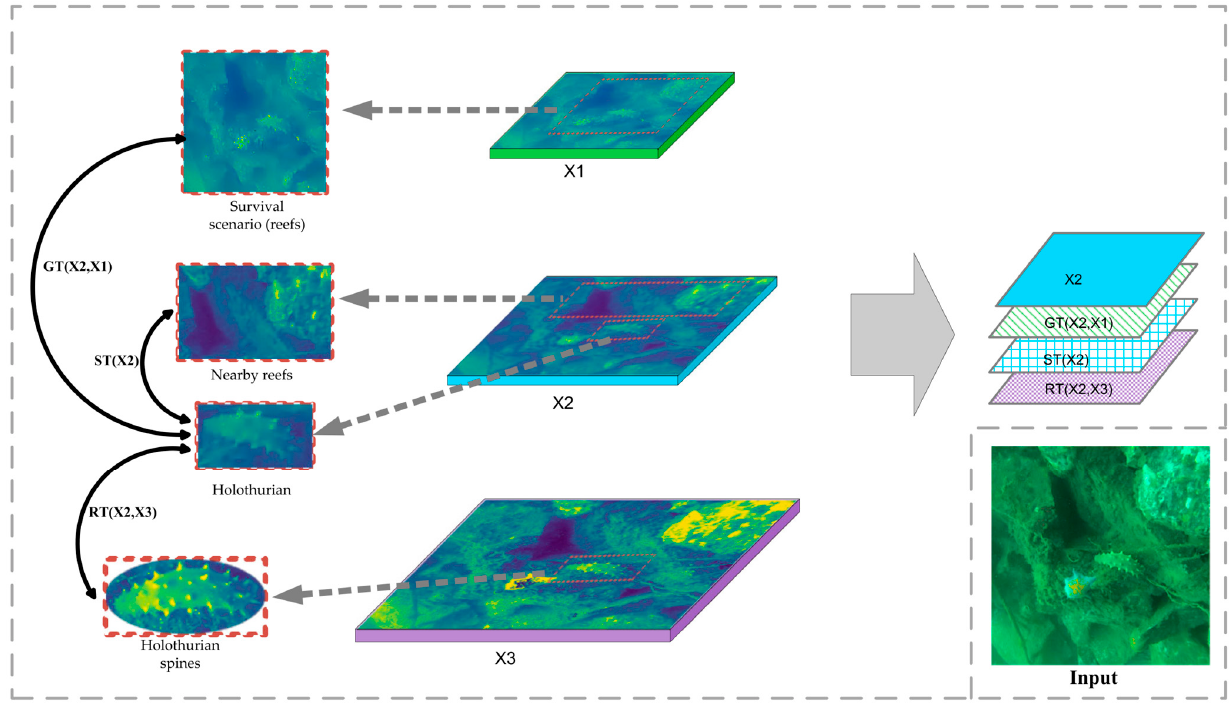
Figure 5. FPT feature interaction diagram.